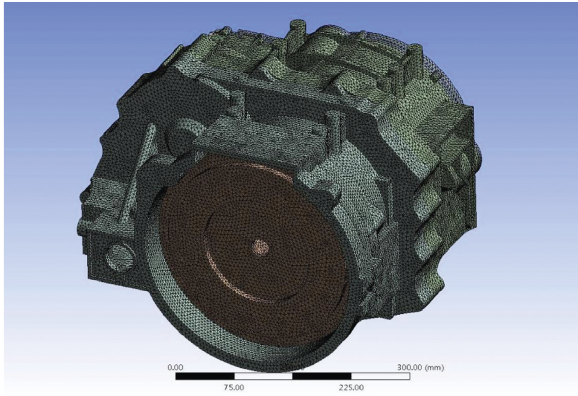
Figure 5: Finite element model of the housing.